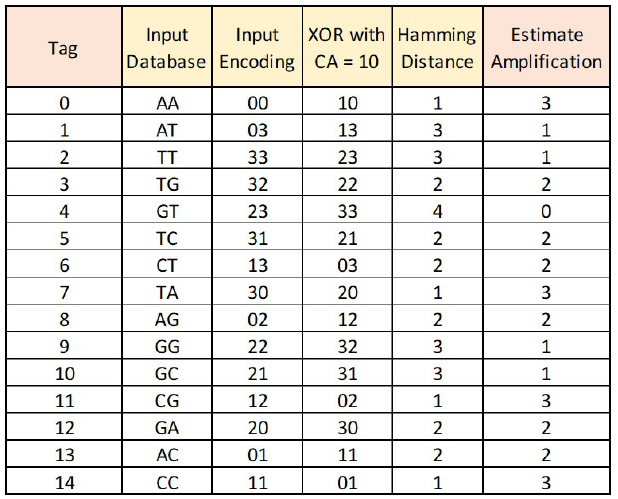
Figure 9. Quantum database for search pattern CA and reference string AATTGTCTAGGCGACC .